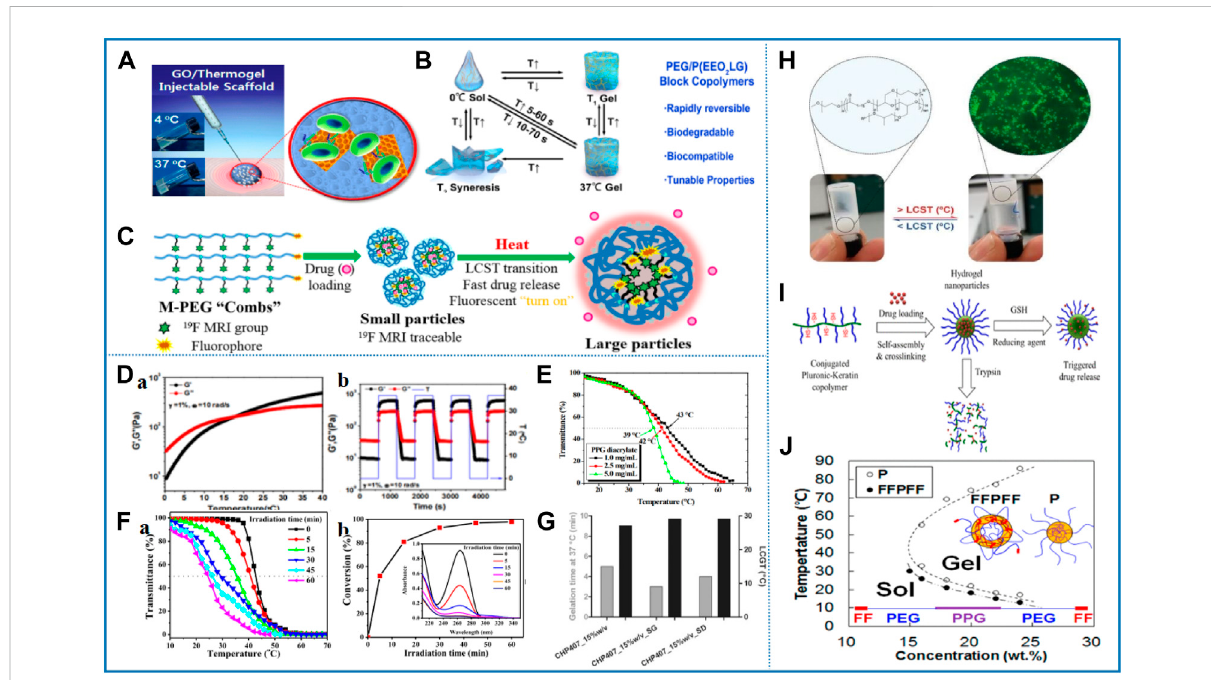
FIGURE 5 Representative studies of thermosensitive nanomaterials based on polyether. (A) Composite system of graphene oxide and polypeptide thermogelasaninjectable3Dscaffoldforadipogenicdifferentiationoftonsil-derivedmesenchymalstemcells.ReprintedwithpermissionfromPatel et al. (2016). Copyright © 2016 American Chemical Society. (B) Temperature-dependent reversible sol − gel − sol transition of PEG/P (EEO 2 LG) hydrogels and the principal characteristics of the PEG/P (EEO 2 LG) hydrogels. Reprinted with permission from Zhao et al. (2021). Copyright © 2021 American Chemical Society. (C) Peptidic monodisperse PEG “ combs ” with fi ne-tunable LCST and multiple imaging modalities. Reprinted with permission from Zhu et al. (2019). Copyright © 2019 American Chemical Society. (D) Quantitative characterization of thermal sensitivity of injectable self-healing hydrogel with antimicrobial and antifouling properties. Reprinted with permission from Li et al. (2017). Copyright © 2017 American Chemical Society. (E) Transmittancecurves ofvariousconcentrationsofPPG diacrylateinwater.ReprintedwithpermissionfromChengetal.